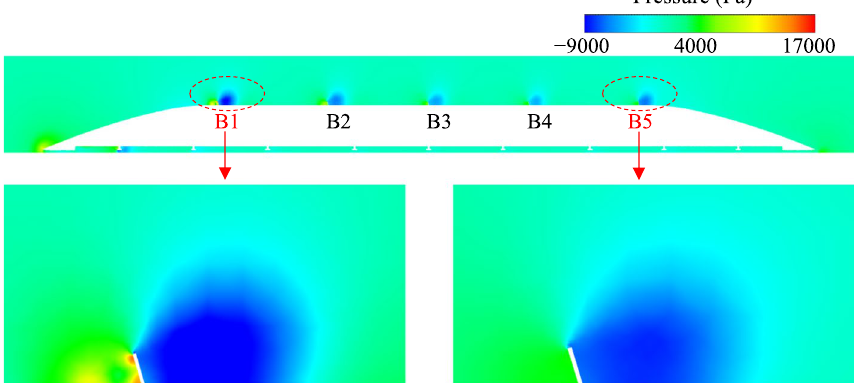
Fig. 11 The pressure distribution of maglev train and near braking plates